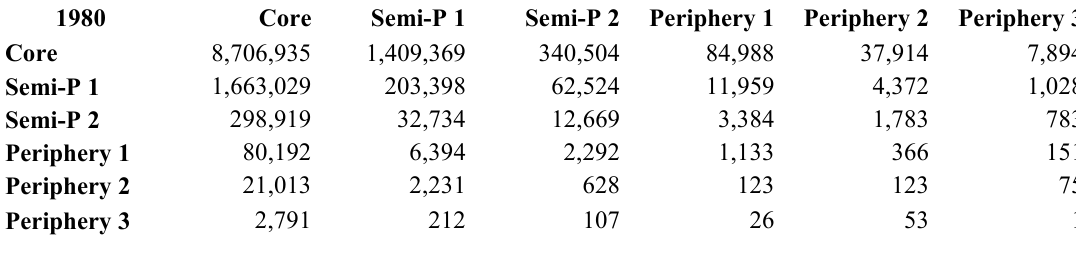
Table 3: Values Represent Average Trade Within and Between Blocks in Thousands of US Dollars 1980 Core